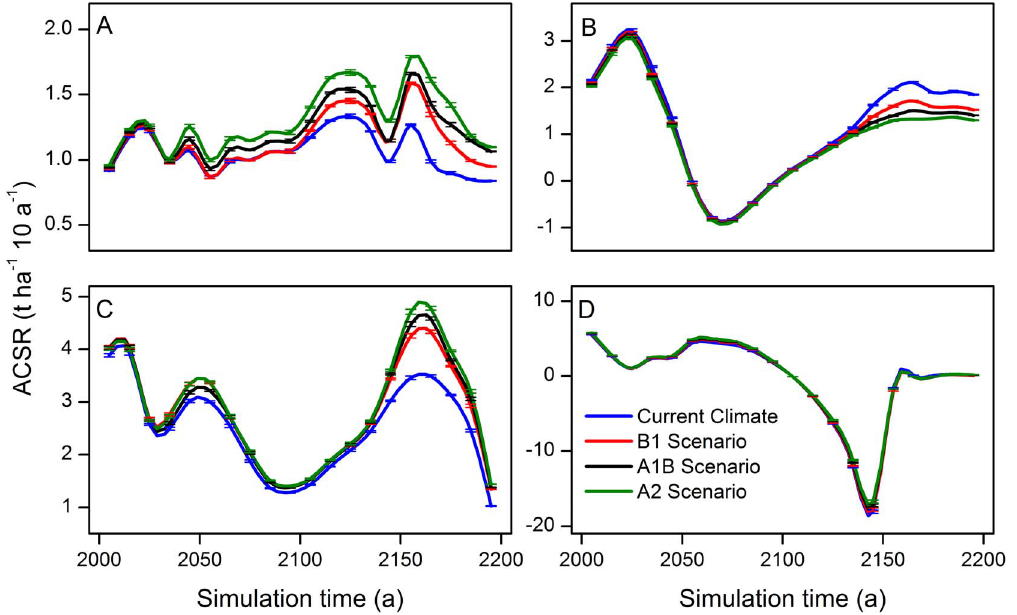
Figure 2. Forest aboveground carbon sequestration rates of different forest communities. A: Mixed Korean pine hardwood forests, B: Spruce-fir forests, C: Mixed larch hardwood forests, and D: Aspen-white birch forests.